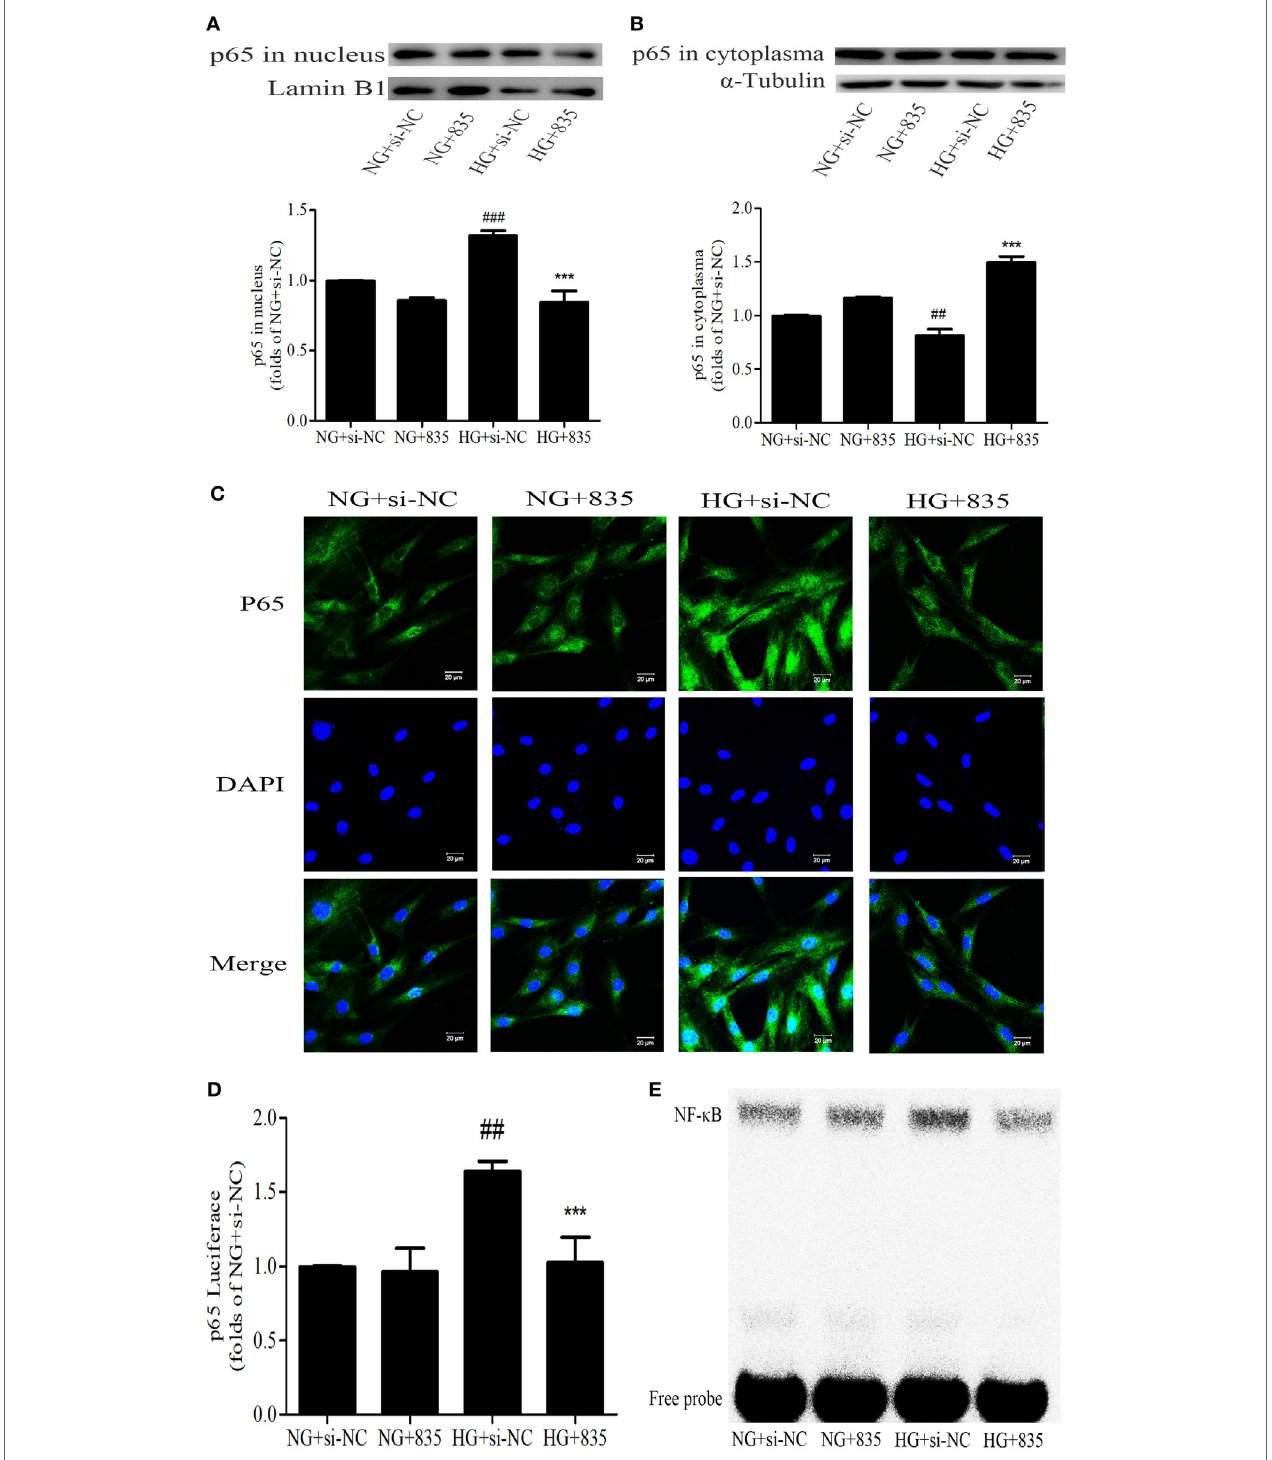
FigUre 6 | Progestin and adipoQ receptor 3 (PAQR3) inhibition suppressed the NF- κ B nuclear translocation, DNA binding, and transcriptional activity in glomerular mesangial cells. High glucose (HG) stimulation increased p65 nuclear translocation, treatment with si835 decreased the nuclear level of p65 (a) and increased its cytoplasm level (B) . ## P < 0.01, ### P < 0.001 vs. NG + si-NC, *** P < 0.001 vs. HG + si-NC. HG-induced nuclear accumulation of p65 was prohibited under the conditions of PAQR3 inhibition (c) . Bar: 20 µm. HG stimulation for 12 h increased p65 transcriptional activity, which was inhibited by treatment with si835 (D) . ## P < 0.01 vs. NG + si-NC, *** P < 0.001 vs. HG + si-NC. Knockdown of PAQR3 decreased the DNA binding activity of p65 compared with HG group (e) . Independent experiments were performed at least three times with similar